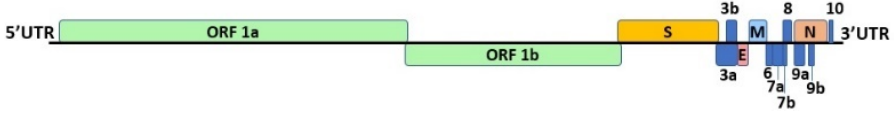
Figure 2. The set of genes making up the SARS-CoV 2